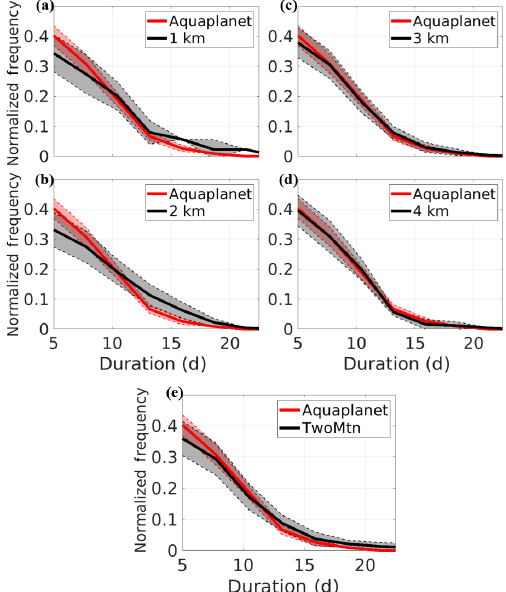
Figure 8. Block duration probability density distributions for the aquaplanet and “East” blocks (as defined in Table 1) in the (a) Sin- gleMtn 1km, (b) SingleMtn 2km, (c) SingleMtn 3km, (d) Sin- gleMtn 4km, and (e) TwoMtn configurations. Thick lines denote the mean probability density distribution for each configuration. Shaded regions bordered by dotted lines outline ± 1 full standard deviation from the